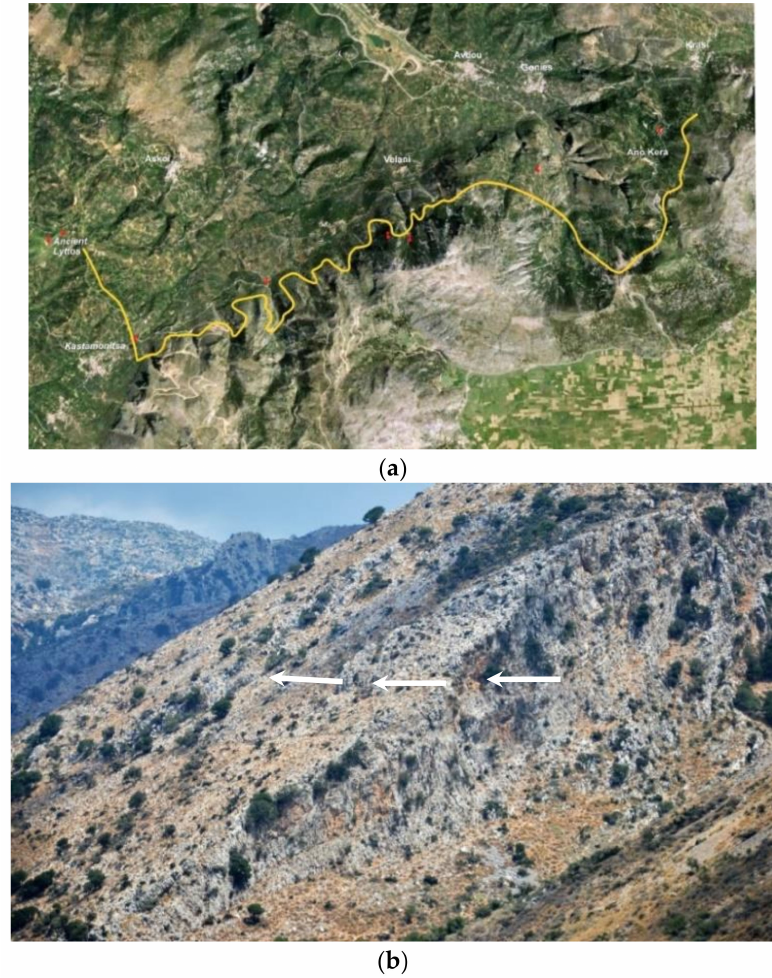
Figure 5. Lyttos aqueduct: ( a ) Aerial photograph overlaid with Oikonomakis (after [27]) and ( b ) the pass of the aqueduct in the location of Petrokopoio (photo by A. N. Angelakis).